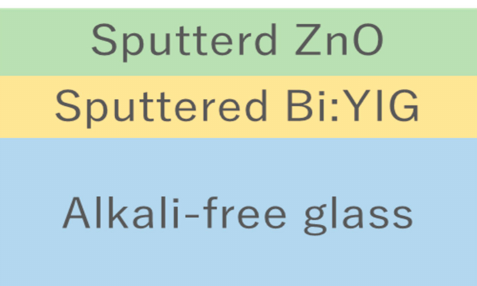
Figure 2. Representation of a cross-section of a fabricated ZnO/bismuth-substituted yttrium iron garnet (Bi:YIG)